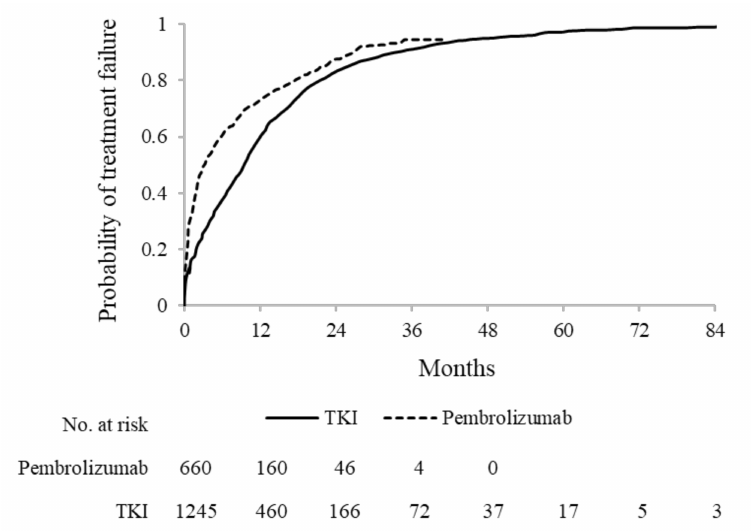
Figure 1. Kaplan-Meier estimates of time-to-treatment failure among 660 and 1245 advanced NSCLC patients treated, respectively, with first-line pembrolizumab and tyrosine-kinase inhibitors